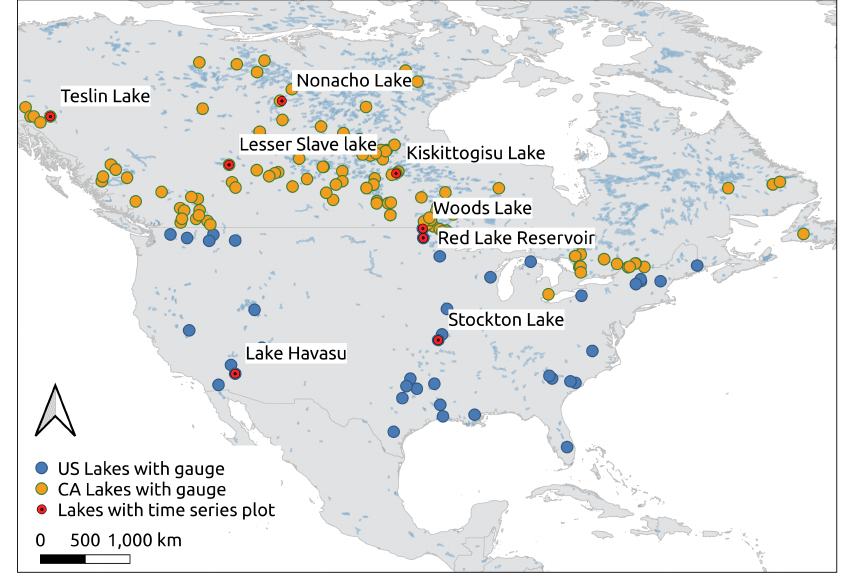
Figure 1. Map displaying the location of the in situ level data which is used in the evaluation. The red dots indicates the location of the selected lakes where lake level time series are